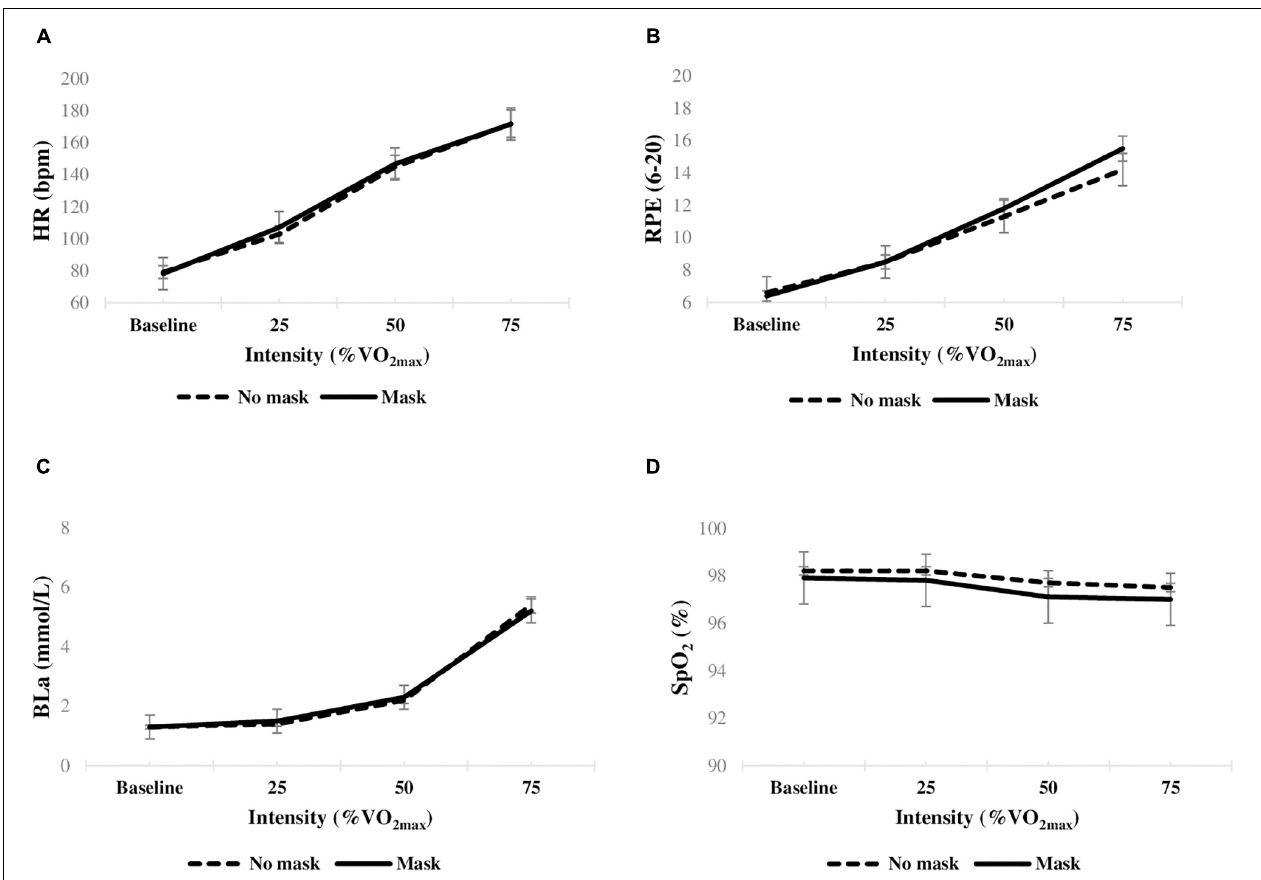
FIGURE 1 | Mean changes in physiological and perceptual parameters ( n = 13) during exercise with and without a surgical mask. (A) HR heart rate; (B) RPE rating of perceived exertion; (C) BLa blood lactate concentration; (D) SpO 2 oxygen saturation level. * p < 0.05.